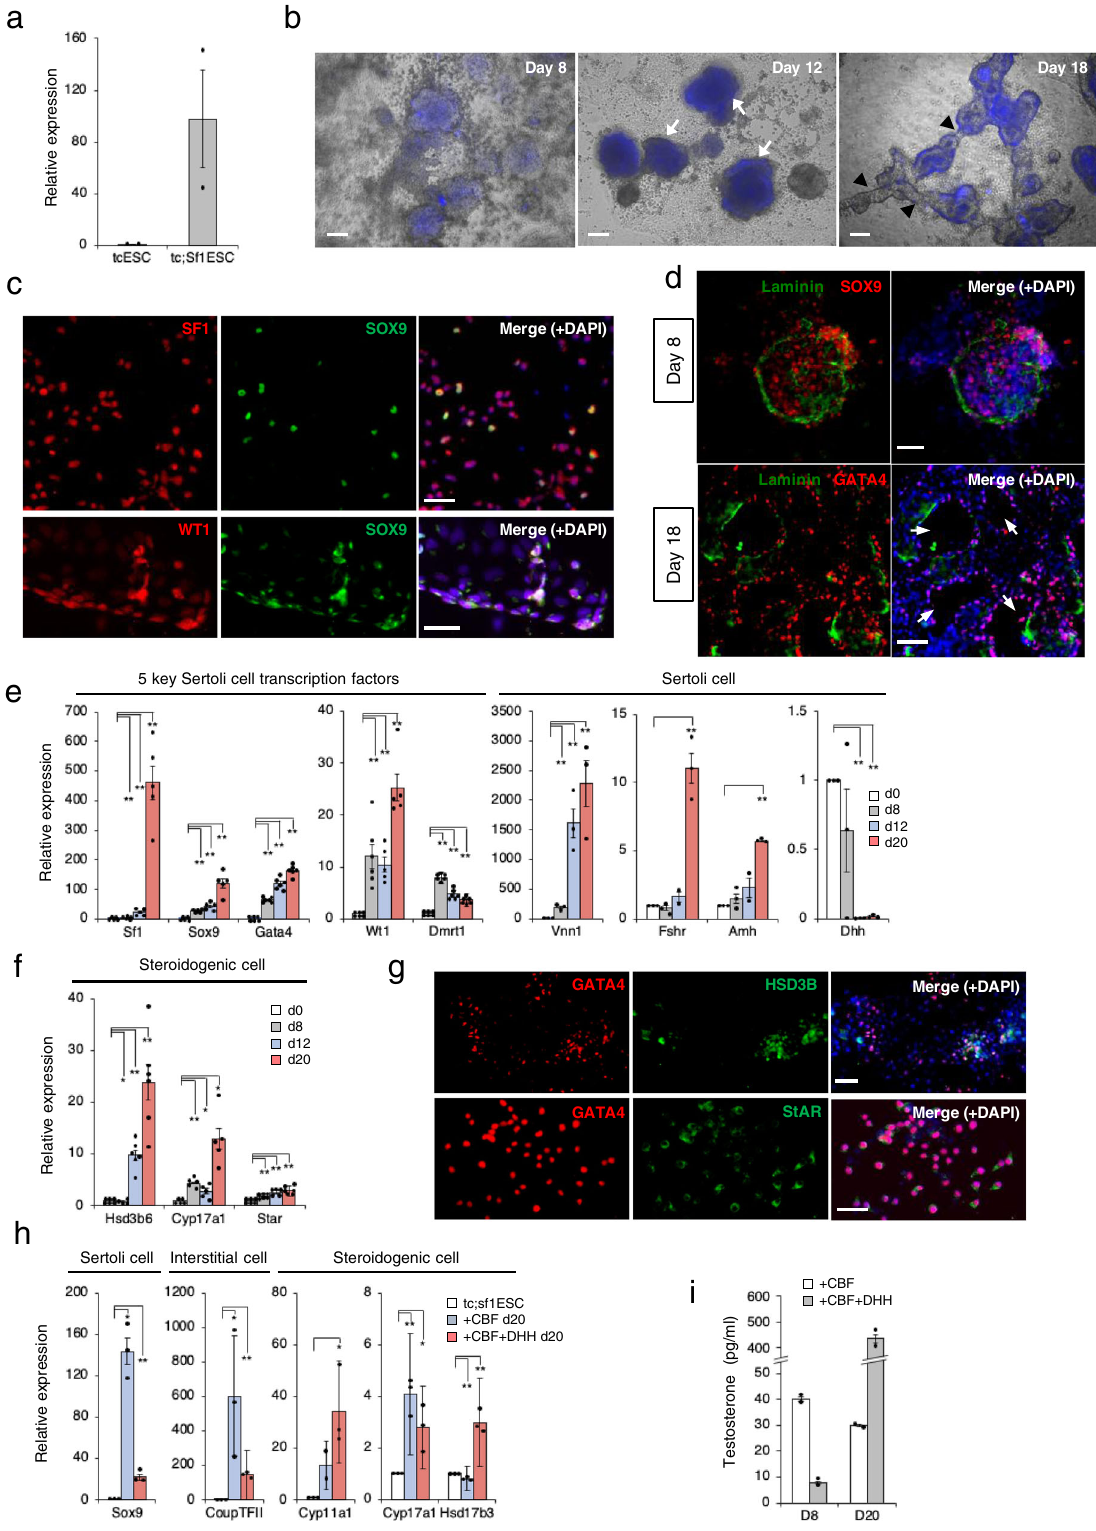
encapsulated by CFP-positive SCLCs (Fig. 3d). The testicular organoid-derived PGCLCs, or tod-PGCLCs, were MVH-positive and resided on the edges of the seminiferous tubule-like structure where SOX9-positive SCLCs were bounded by a layer of laminin (Fig. 3d). Flow cytometry analysis revealed that 2% of the organoid cells were GFP/CD49f-double positive PGCLCs